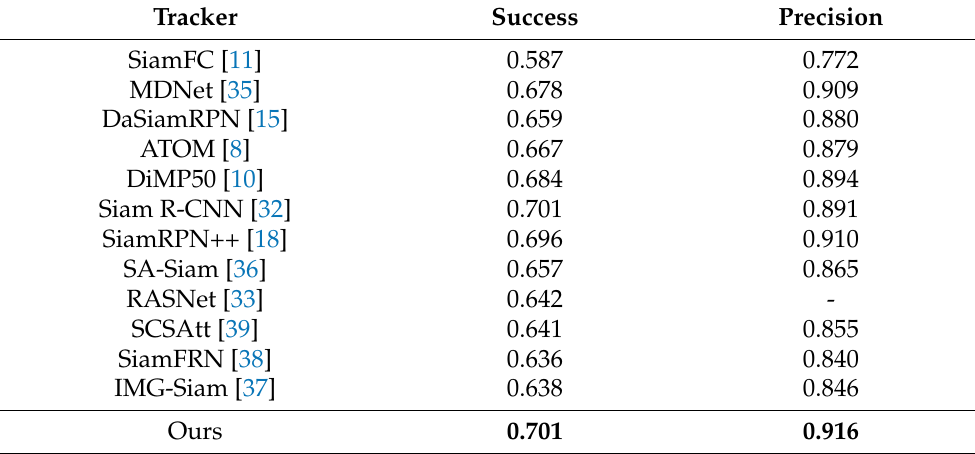
Figure 7. Comparison chart of OTB dataset. Table 1. Experimental results of our algorithm and other algorithms on the OTB2015 dataset. The bolded values in the table are the best